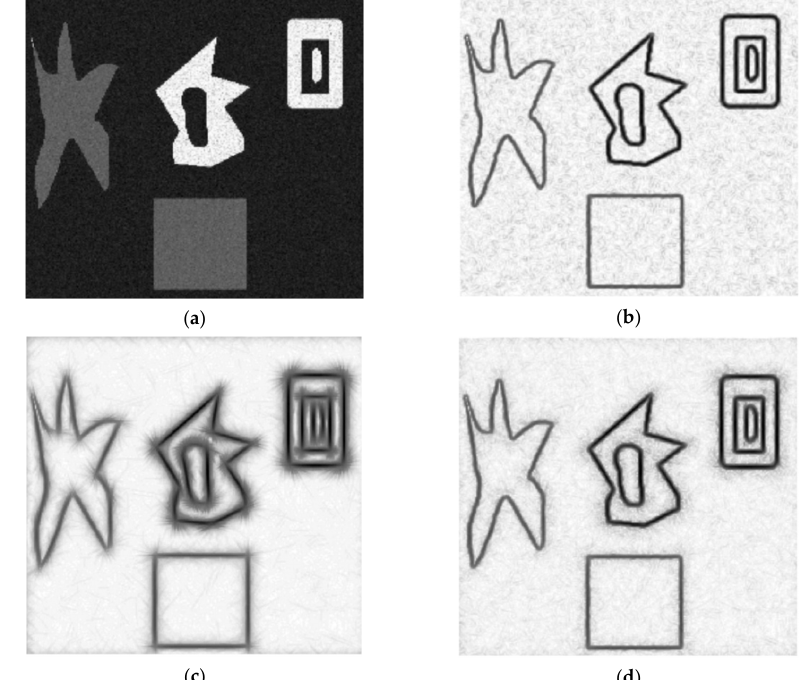
Figure 2. Illustration of the edge strength maps (ESMs) of a noisy image: (a) a noisy synthetic cartoon image with noise; (b) small-scaled gradient-based ESM; (c) ANDD-based ESM with the same edge resolution; (d) fused ESM.